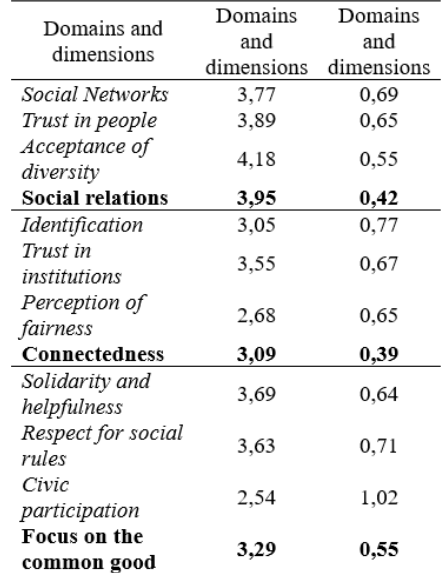
Table 4. Results of the evaluation of